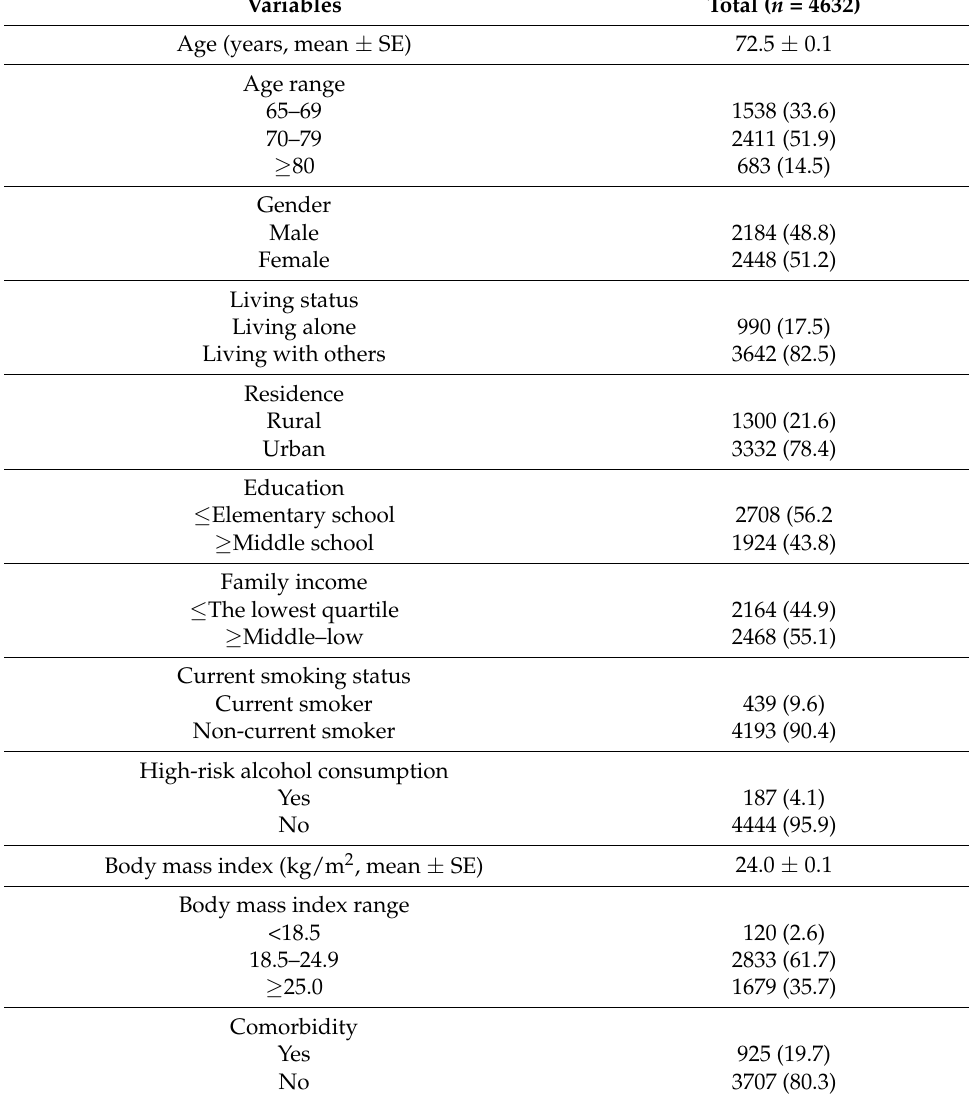
Table 1. General characteristics of the study